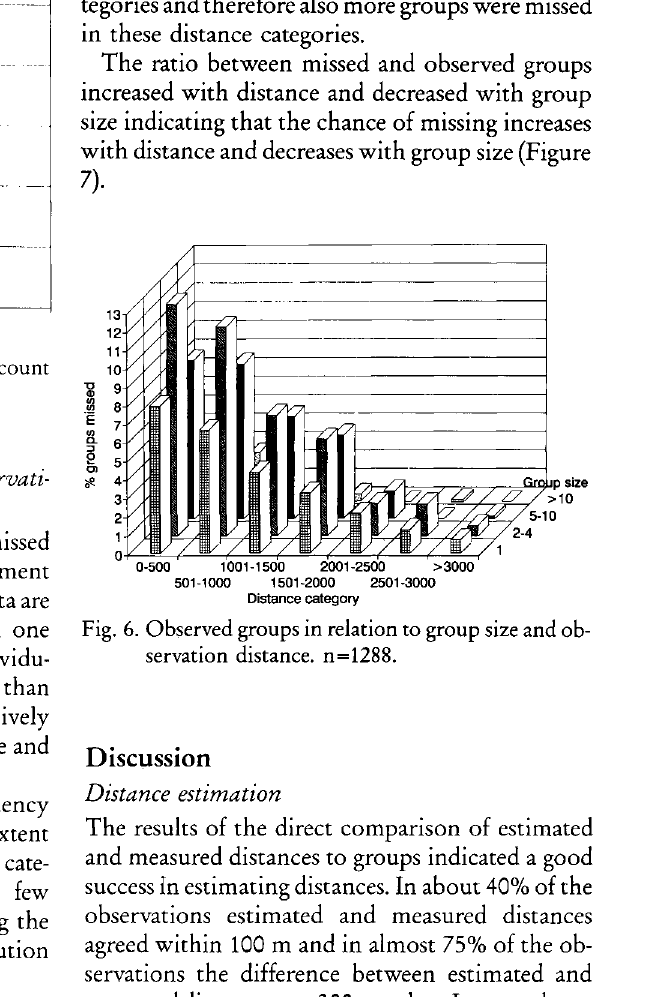
Fig. 4. Double-observer experiment. Difference in count of groups. n=181.